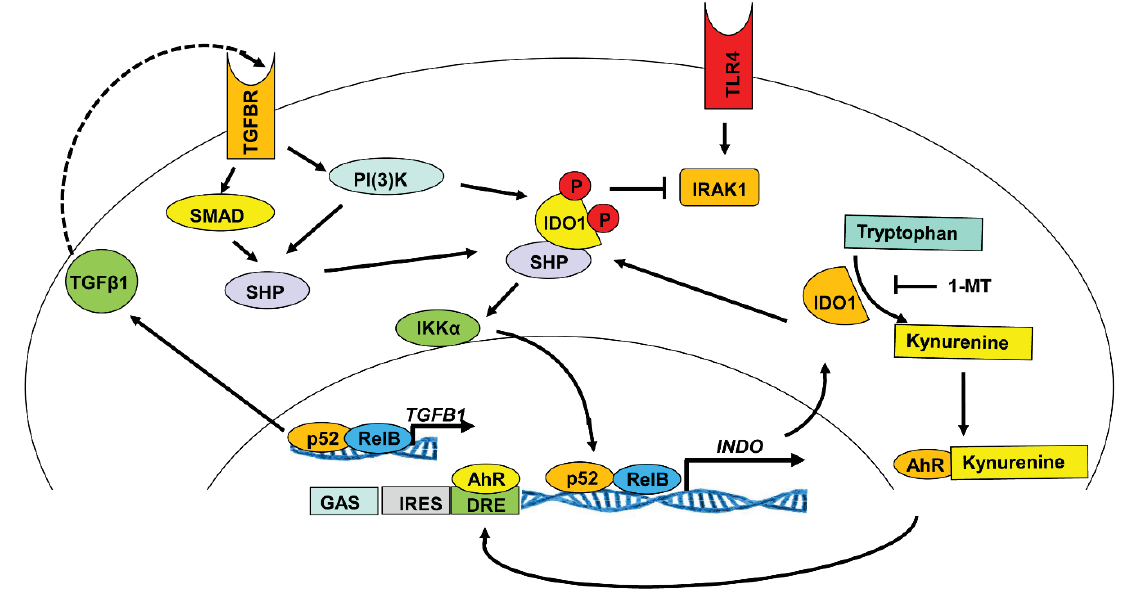
Figure 3. The TGF-(cid:5)-IDO-SHP axis. The TGF-(cid:5)-IDO-SHP axis activates the non-canonical NF-(cid:2)B pathway [49]. In splenocytes, SHP-1 inhibits the protein kinase IRAK1 and tips